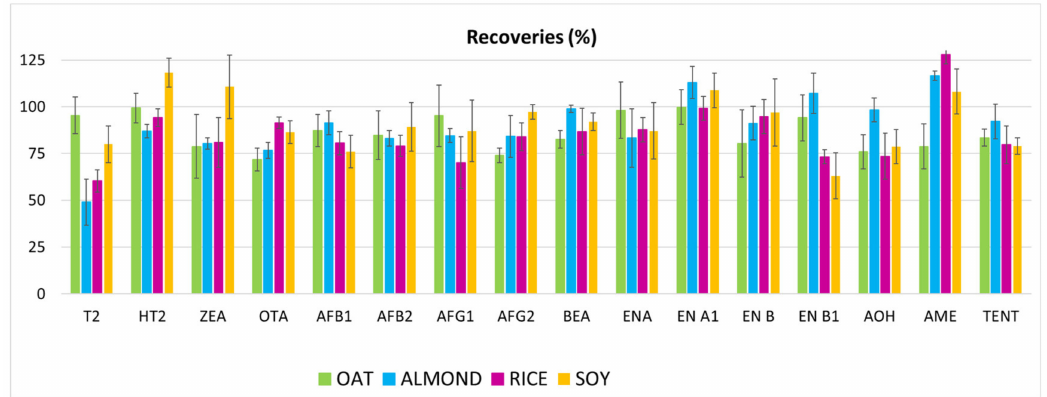
Figure 5. Recoveries obtained from the repeatability study (n = 3) at the L1 level for the four matrices.